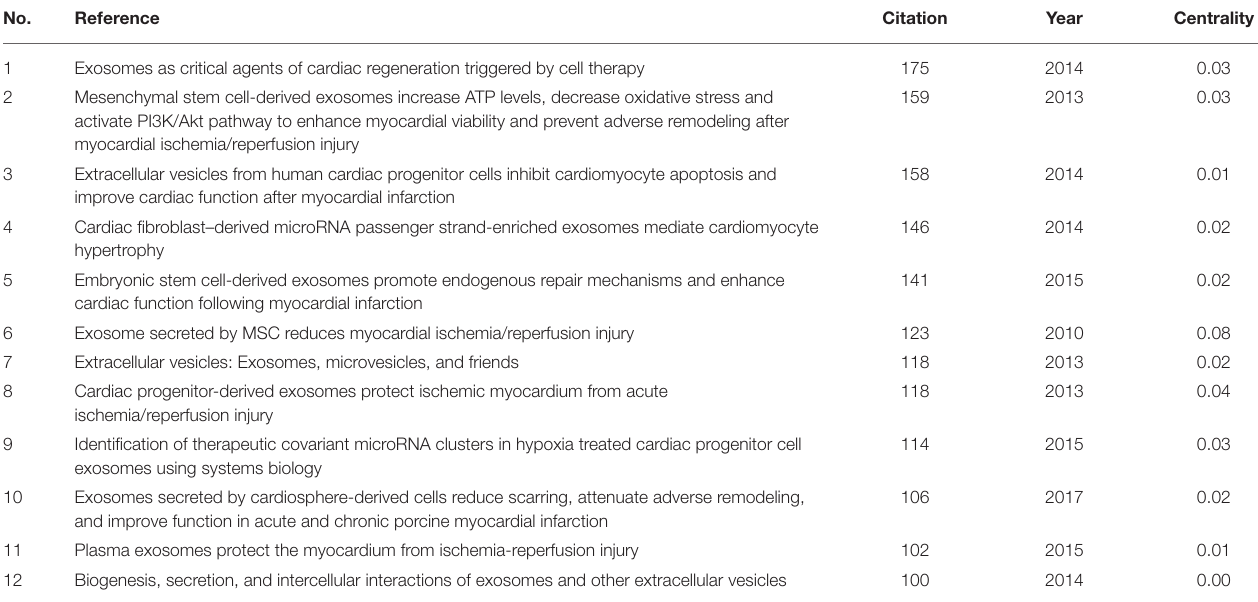
TABLE 4 | Top 12 co-cited references related to exosomes in